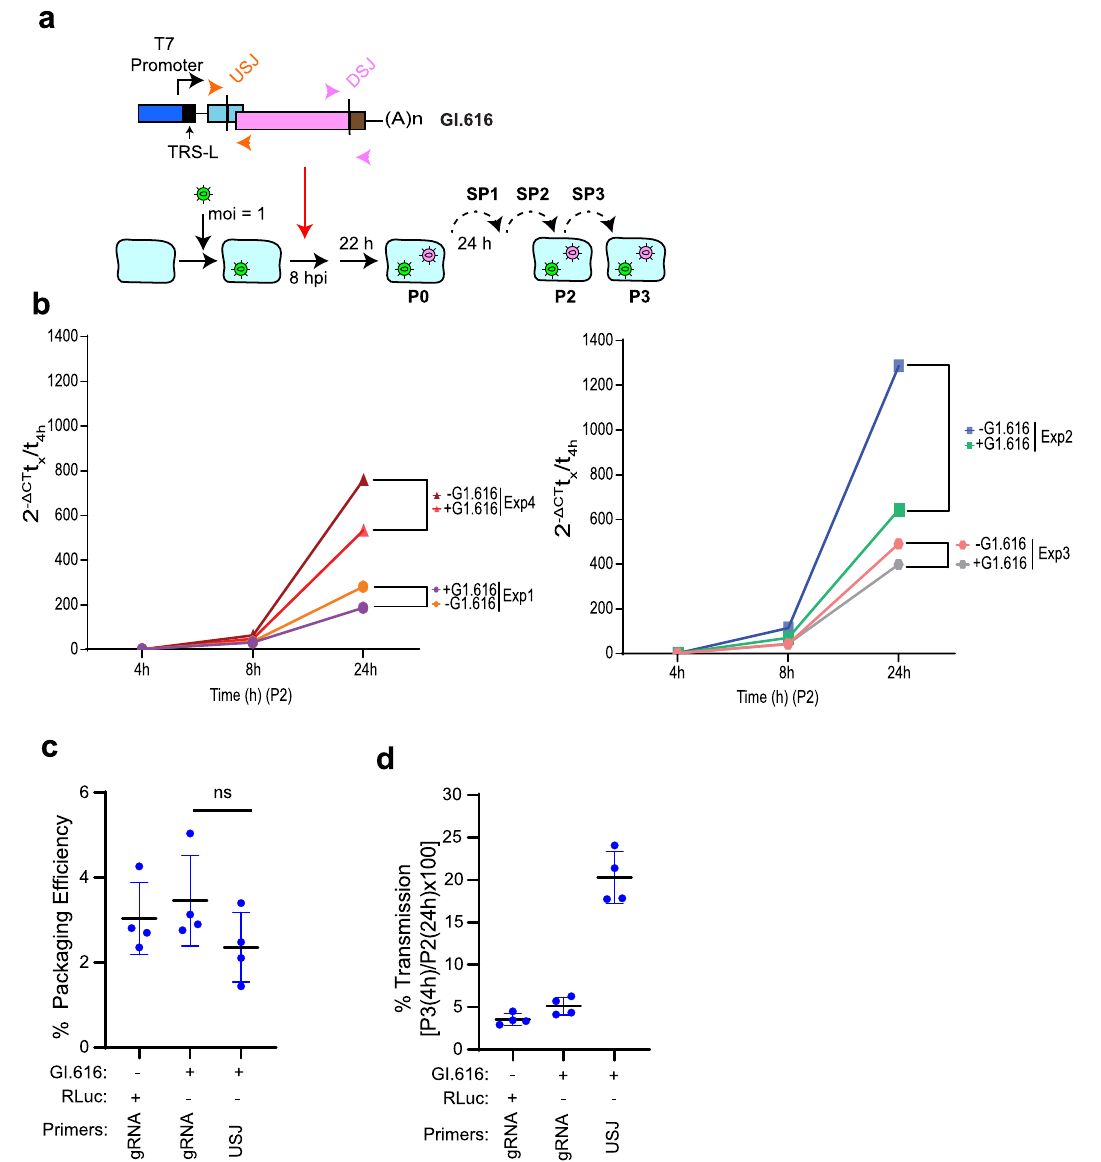
Fig. 4 Interference of SARS-CoV-2 replication by GI.616. a Schematic diagram showing experimental design for assessing the effect of GI.616 on SARS- CoV-2 replication. SARS-CoV-2 and GI.616 genomes were isolated from P2 and P3 cells, as well as SP3 supernatant. b Growth rates (absolute gRNA levels relative to the amount at 4 h) of parental virus propagated in the presence of GI.616 ( + ) or RLuc ( − ). The data for four independent experiments is shown. c The percent packaged genomes upon propagation of SARS-CoV-2 in the presence or absence of GI.616. n = 4 independent biologically experiments ± SD. ns, not signi fi cant ( p = 0.25). d Transmission ef fi ciency of SARS-CoV-2 and GI.616. n = 4 independent biological experiments ±